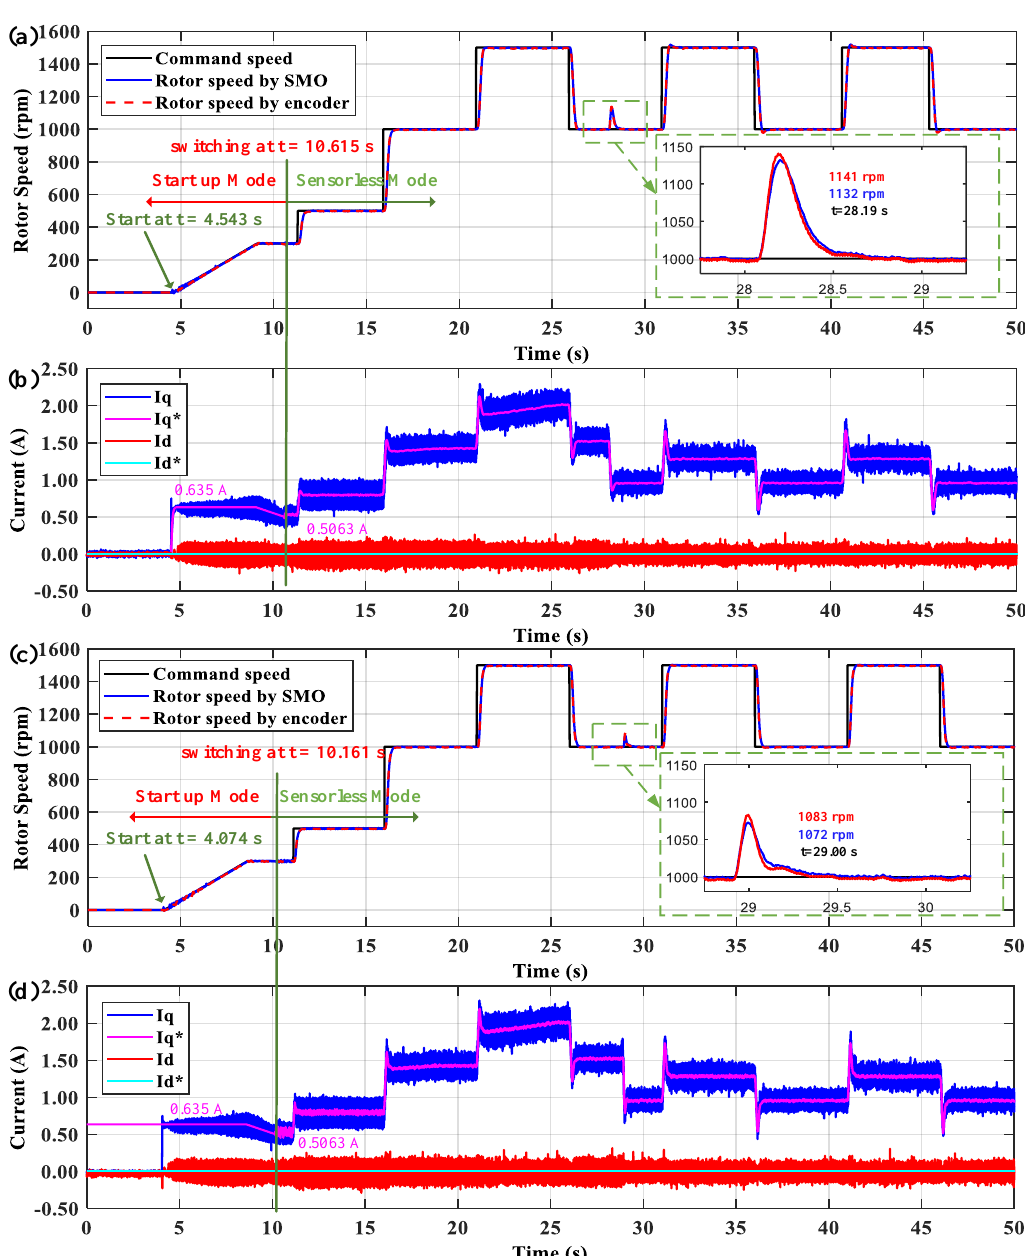
Figure 21. Experimental results for PI controller: ( a ) speed response; ( b ) current response; and for NFC controller: ( c ) speed response; and ( d ) current response in the case of the R L = 50 → 100 Ω.